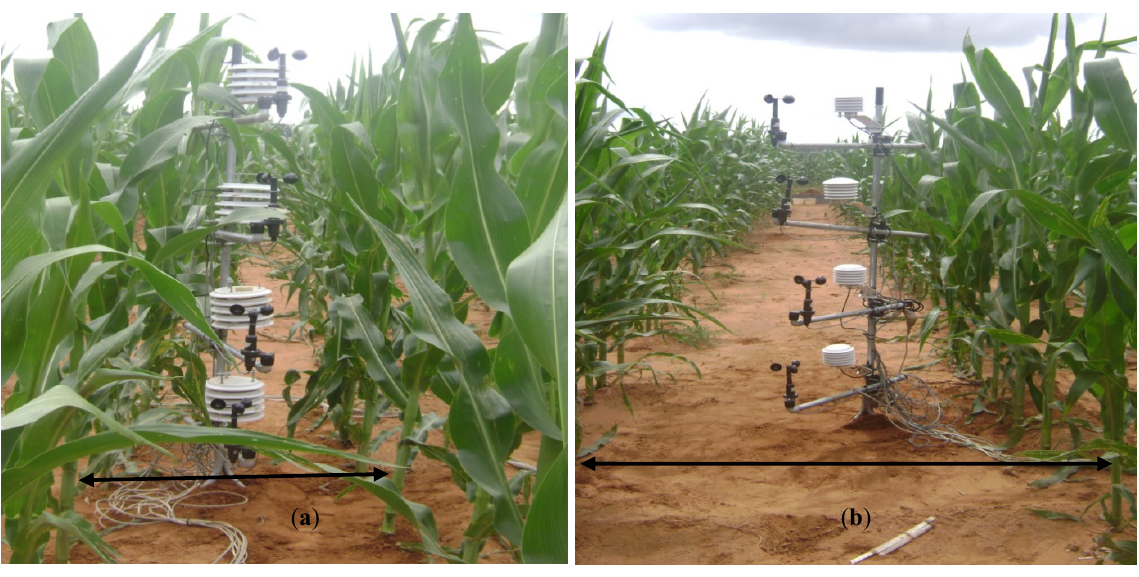
Figure 1. Sensor arrangements in the runoff section within the maize canopy at 1.6 m crop height on 25 February 2009, for the 1.5 m and 3.0 m length runoff strip. ( a ) 1.5 m (Narrow RSL); ( b ) 3.0 m (Wide